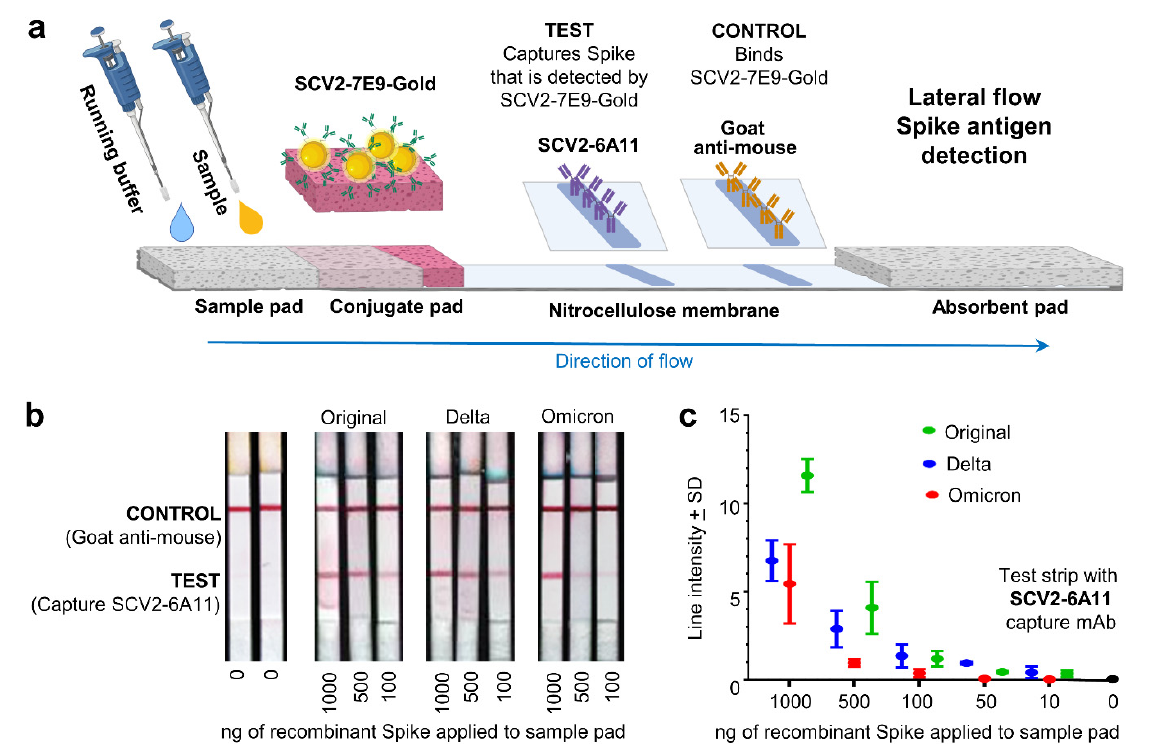
Figure 4. Lateral flow spike antigen detection applications. ( a ) Setup of the lateral flow spike antigen detection system (generated using BioRender). Sample (containing recombinant spike) is applied followed by running buffer, which carries the antigen and mobilizes the gold-conjugated SCV2-7E9 mAb. Spike bound to SCV-6A11 (the capture mAb) is then detected by SCV2-7E9-Gold. The control binds the SCV2-7E9-Gold illustrating that the detection-mAb has been mobilized. ( b ) The SCV2- 7E9-Gold is visualized as a red band that illustrates the presence of recombinant spike in the sample (TEST), with a red CONTROL line illustrating that the detection mAb (SCV2-7E9-Gold) has been mobilized. ( c ) Quantitation of antigen detection by the lateral flow test for recombinant spike antigens from each of 3 variants of concern. (SD from n = 3